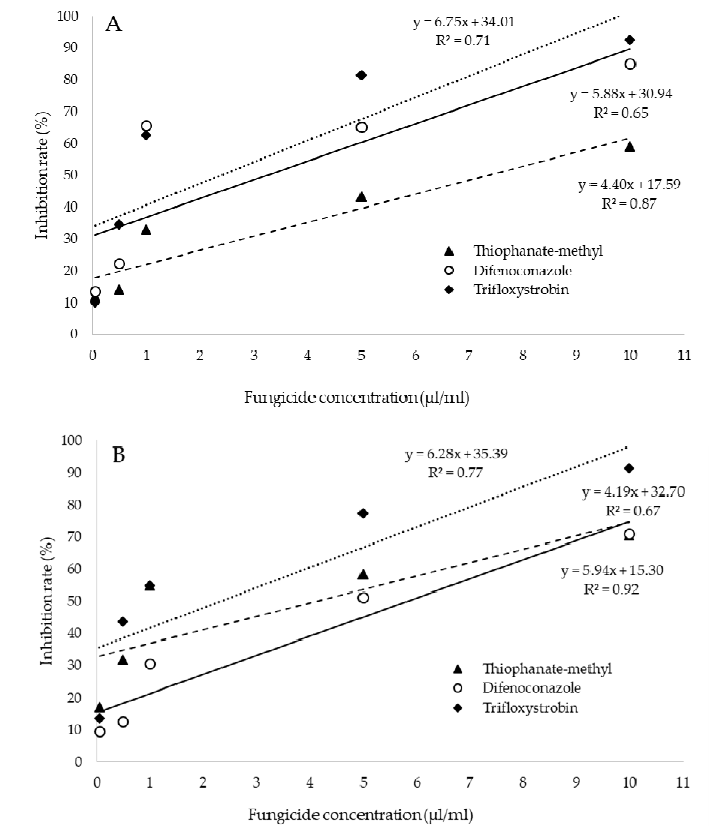
Fig. 3. Effect of three fungicides on the mycelial growth of the two isolates of V. inaequalis ViIF (A) and ViEN